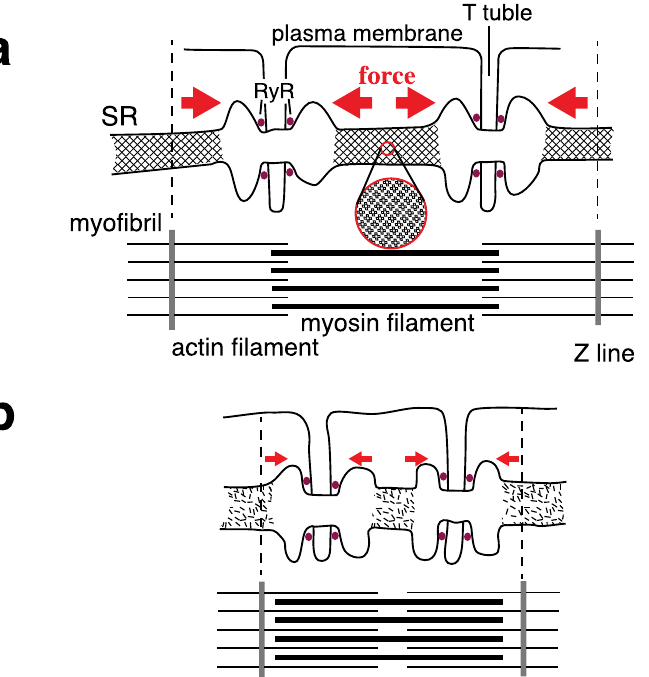
Figure 12. Schematic representation of the formation ( a ) and collapse ( b ) of a crystalline array of the Ca 2+ -ATPase surface particles in the SR of rabbit skeletal muscle, which link with the resting and contracting states of the muscle, respectively.